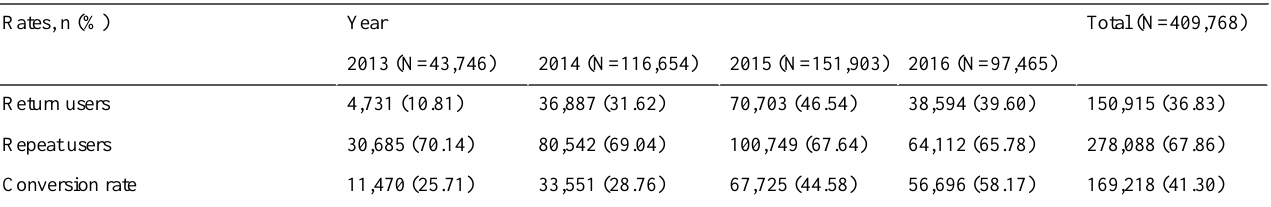
Table 9. Percentage of return and repeat users per